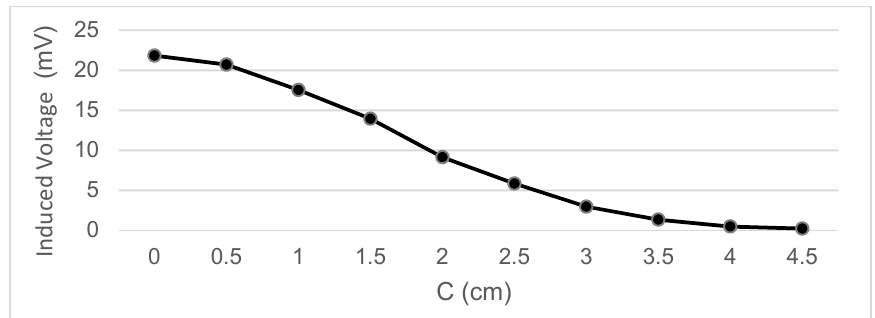
Figure 7. Data representation for B = 16 cm, A = 20 cm; Test 4.4.